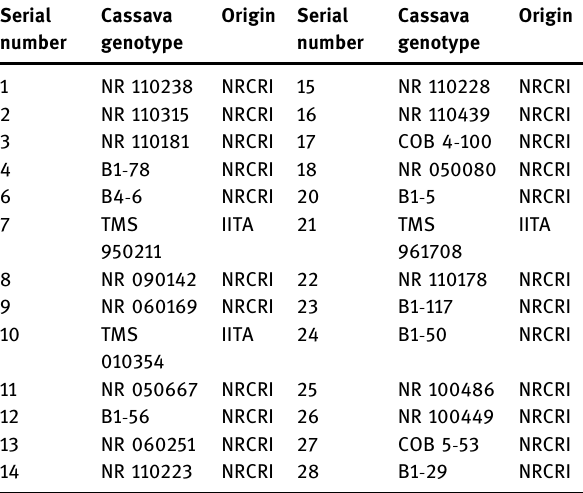
Table 1: Description of the 28 cassava genotypes studied for variation and yield